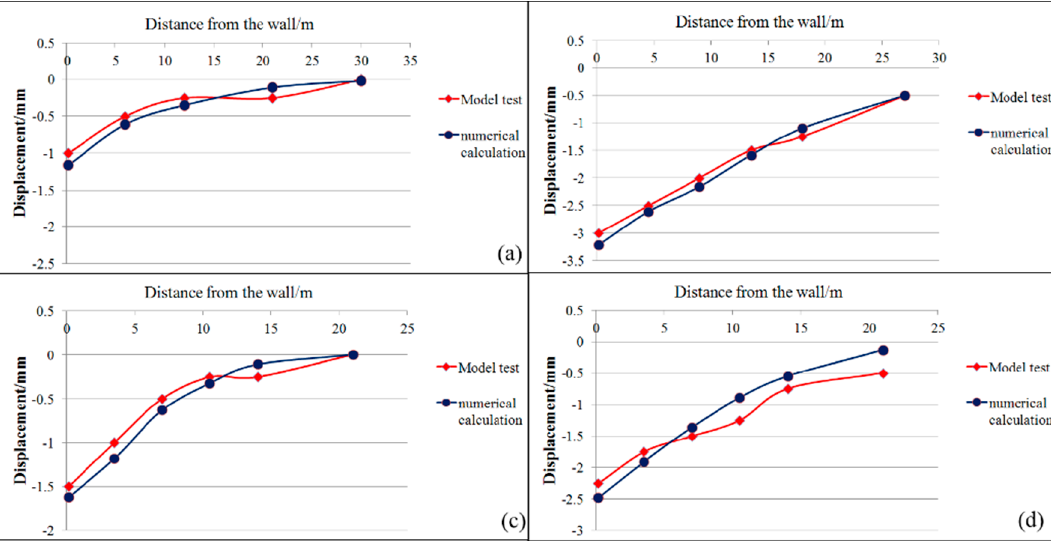
Figure 15. The displacement curves of the experimental results compared with the numerical simulation in different parts. ( a ) The main roadway waist; ( b ) the main roadway vault; ( c ) the parking lot waist; and ( d ) the parking lot vault.